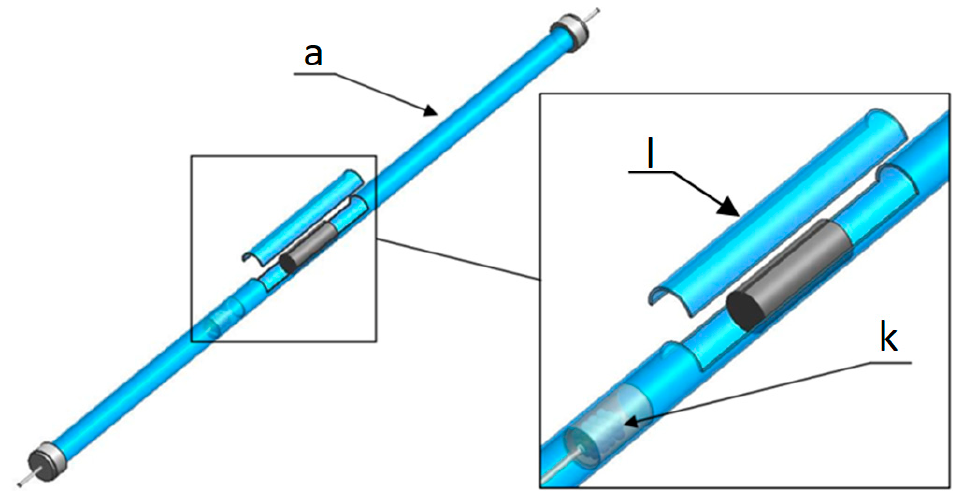
Figure 2. Visualization of a gasification reactor with a coal sample intended for gasification and a steam generator (12): a—reactor, k—steam generator, l—reactor lock.